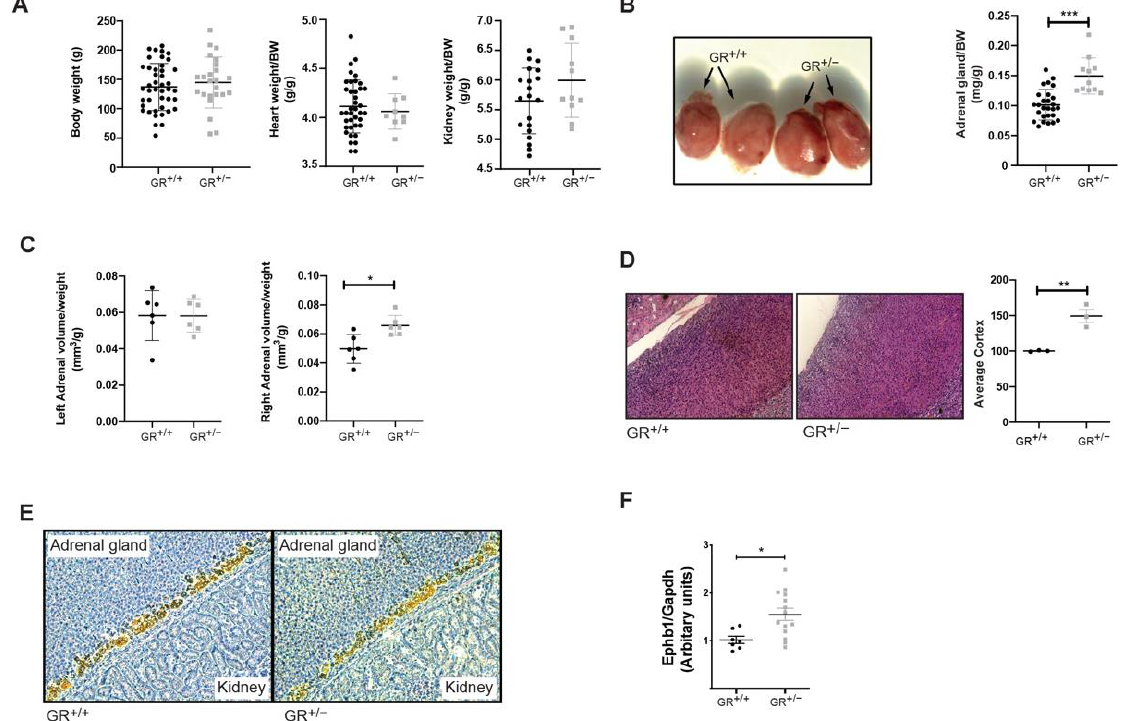
Figure 2. GR +/− rats have enlarged adrenal glands ( A ) Body weight (GR +/+ n = 24; GR +/− n = 43), heart weight (GR +/+ n = 9; GR +/− n = 39) and kidney weight (GR +/+ n = 11; GR +/− n = 20) per body weight. ( B ) Pictures and weight of adrenal glands per body weight from 3-weeks old GR +/+ (n = 25) and GR +/− (n = 11) male rats. ( C ) Volume per body weight of adrenal glands from 8-weeks old GR +/+ (n = 12) and GR +/− (n = 11) male rats. ( D ) H&E staining and its quantification of the size of the zona fasciculata of adrenal glands from 3-week-old GR +/+ (n = 3) and GR +/− (n = 3) male rats. ( E ) CYP11B2 staining of the zona glomerulosa of adrenal glands from 3-week-old GR +/+ (n = 3) and GR +/− male rats (n = 3). ( F ) Gene expression of Ephb1 in the adrenal glands of GR +/+ (n = 7) and GR +/− rats (n = 14) in StD. Values are indicated as mean ± SEM, and data were evaluated by unpaired two-tailed t test and differences assessed at * p < 0.05, ** p < 0.01 or *** p < 0.001.